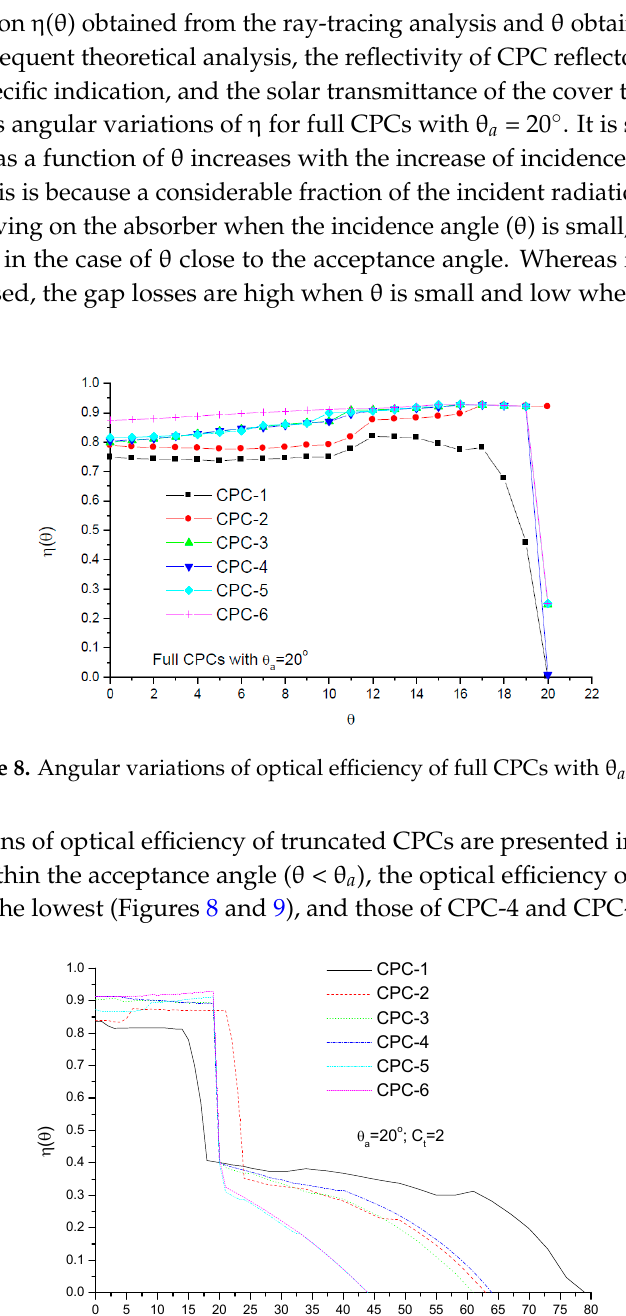
Figure 9. As in Figure 8 but for truncated CPCs with θ a = 20° and C t = 2.